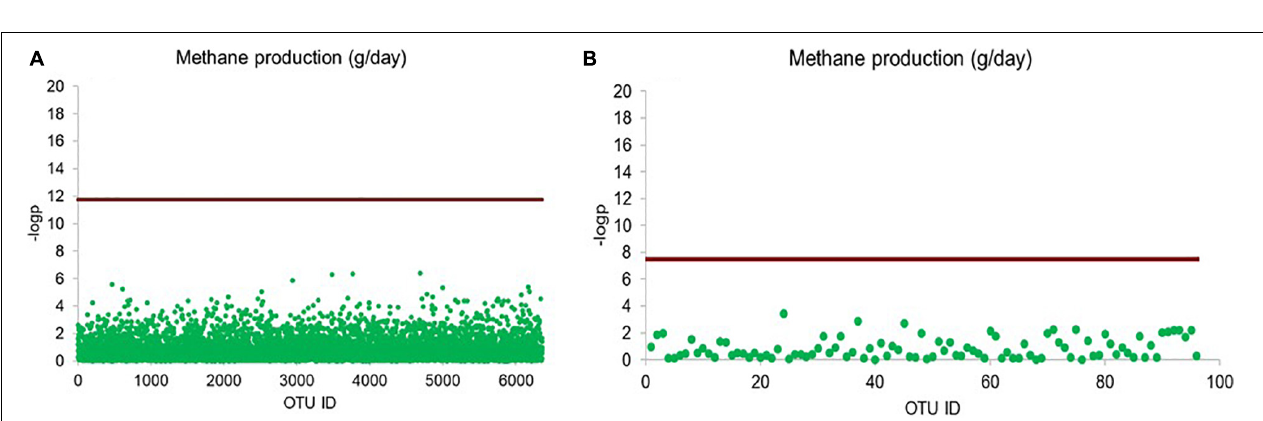
Frontiers in Microbiology |